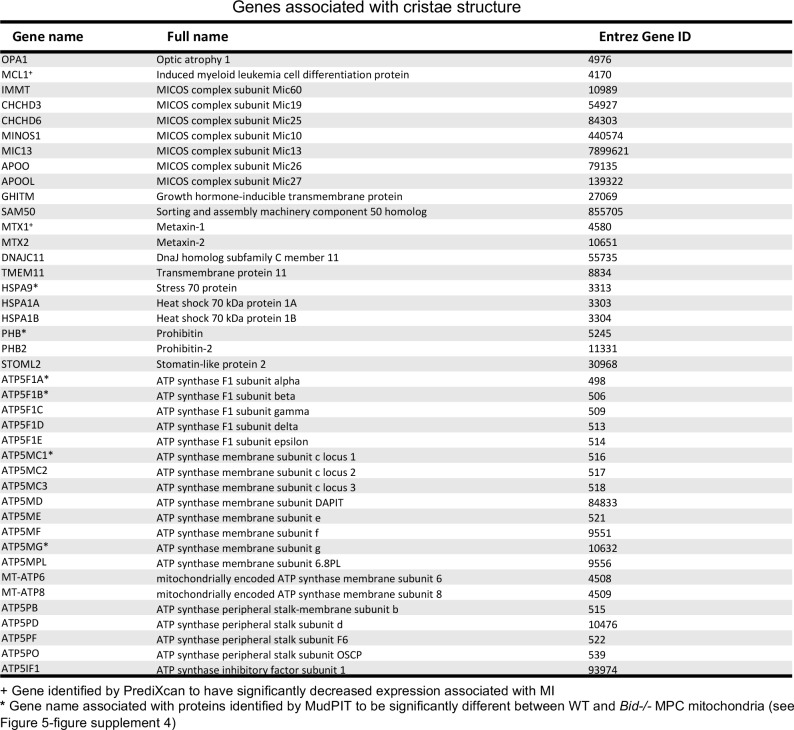
Table of cristae structure associated genes analyzed by PrediXcan.A total of 41 genes with known associations to cristae structure. Genes are identified by their names and unique Entrez Gene ID.